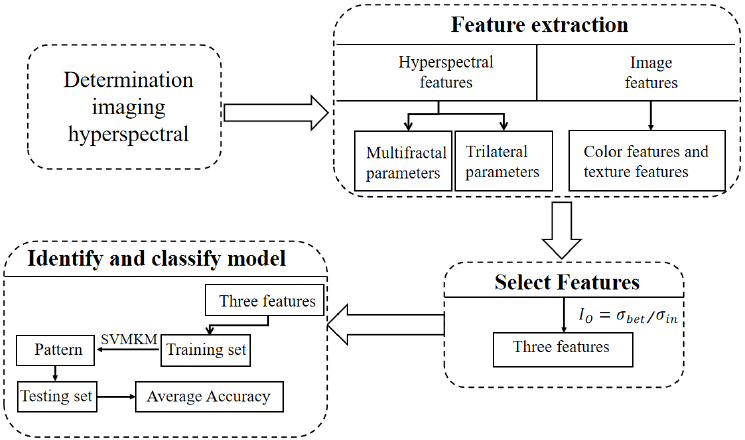
Figure 2. Flowchart of rapeseed variety identification.